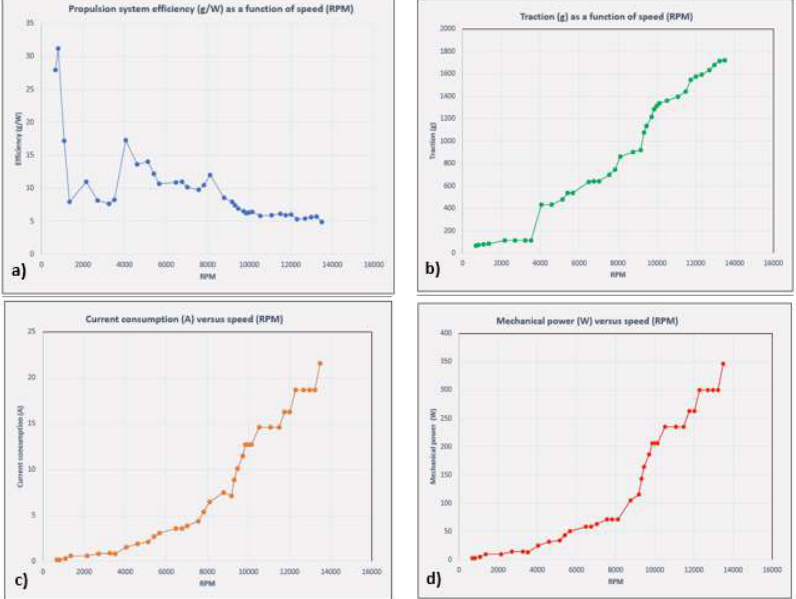
Figure 14. Propulsion system tests results. ( a ) Propulsion system efficiency; ( b ) Traction force as a